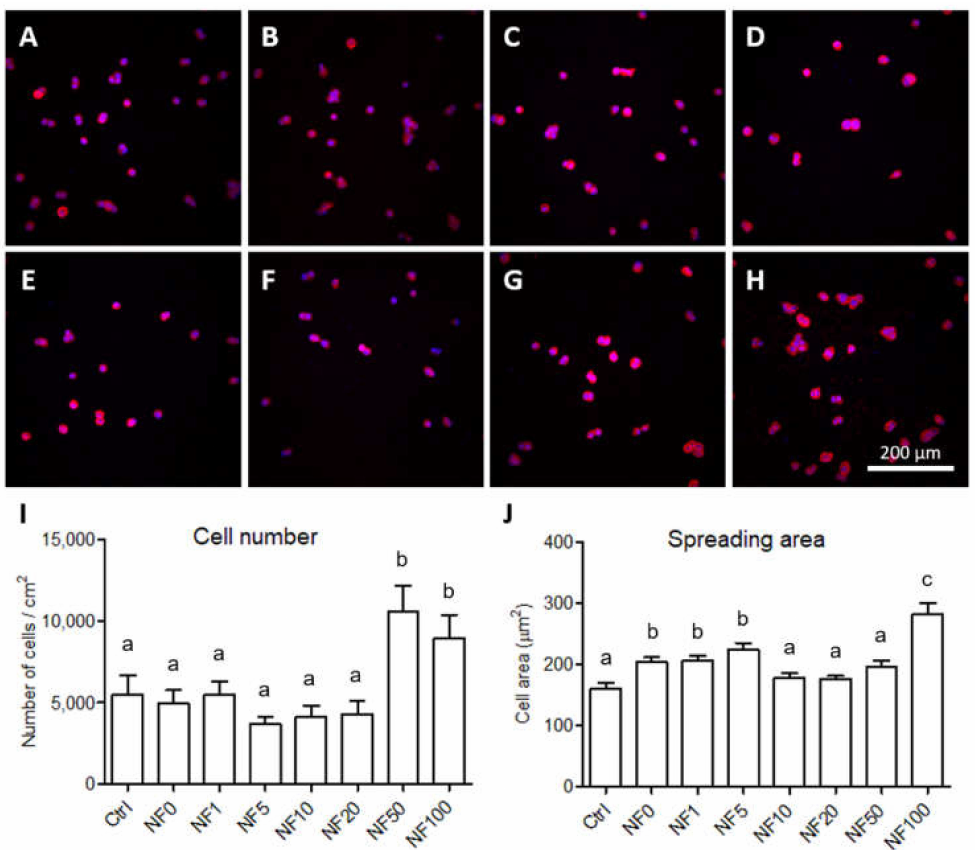
Figure 5. HaCaT cells that adhered to the pure NF membranes (Ctrl, A ) and to the NF membranes with fibrin assemblies containing 0–100 vol.% of PL, i.e., NF0 ( B ), NF1 ( C ), NF5 ( D ), NF10 ( E ), NF20 ( F ), NF50 ( G ) and NF100 ( H ) on day 1 following seeding. Images of the cells stained with phalloidin-TRITC (red); the cell nuclei were counterstained with Hoechst 33,258 (blue). Leica SPE microscope, obj. x 20. The cell population density ( I ) and the spreading area ( J ) of the HaCaT cells on the NF membranes on day 1 following seeding. The data are expressed as the mean ± standard error of the mean. The superscript letters above the columns denote significant differences between the NF membranes that do not share the same superscript ( p <